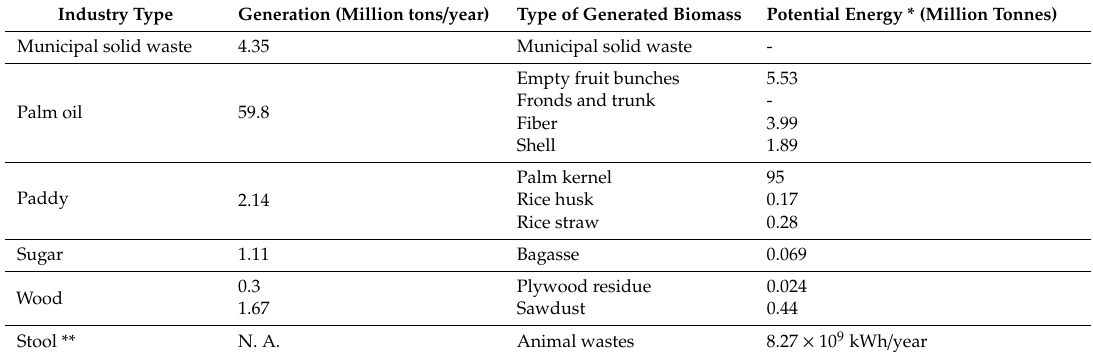
Table 5. Various resources of biomass in Malaysia and their estimated energy potential.